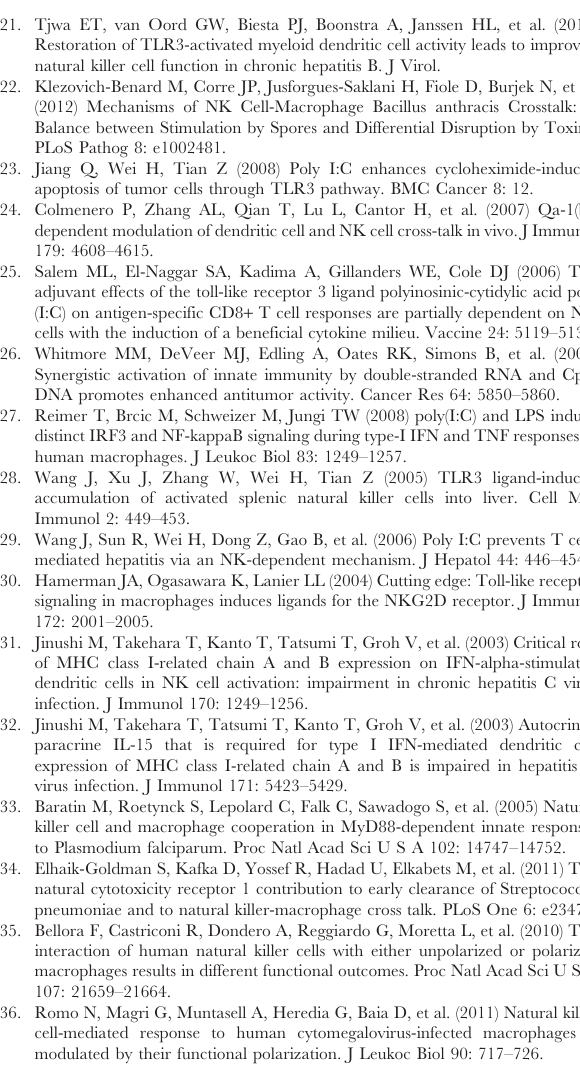
Figure S1 The purity of splenic NK cells isolated from mixed culture cells. NK cells were first co-cultured with macrophages, and then were separated from macrophages. The purity was determined by flow cytometry. The data are expressed at least three separate experiments. Figure S2 NKG2A contributes to the protection of macrophages from NK cell-mediated lysis. Following transfection with either pan-Qa-1 siRNA (si-Qa-1) or si-control complexed with lipofectamine 2000 at a concentration of 100 nM for 24 h, expression of Qa-1a and Qa-1b in RAW264.7 cells was tested by RT-PCR (A). The data are expressed as the fold change in mRNA expression normalized to untreated cells. * p ,